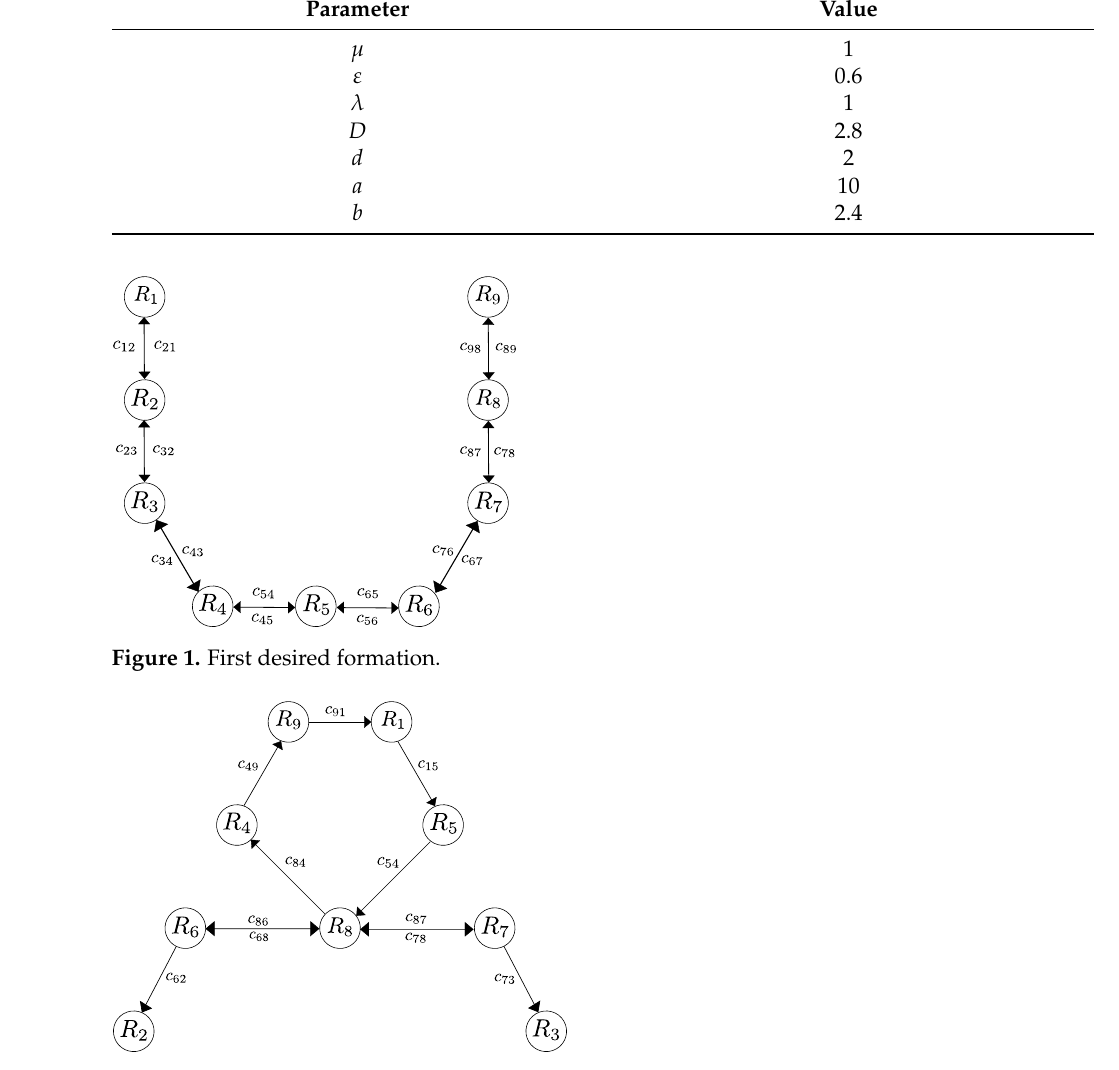
Figure 2. Second desired